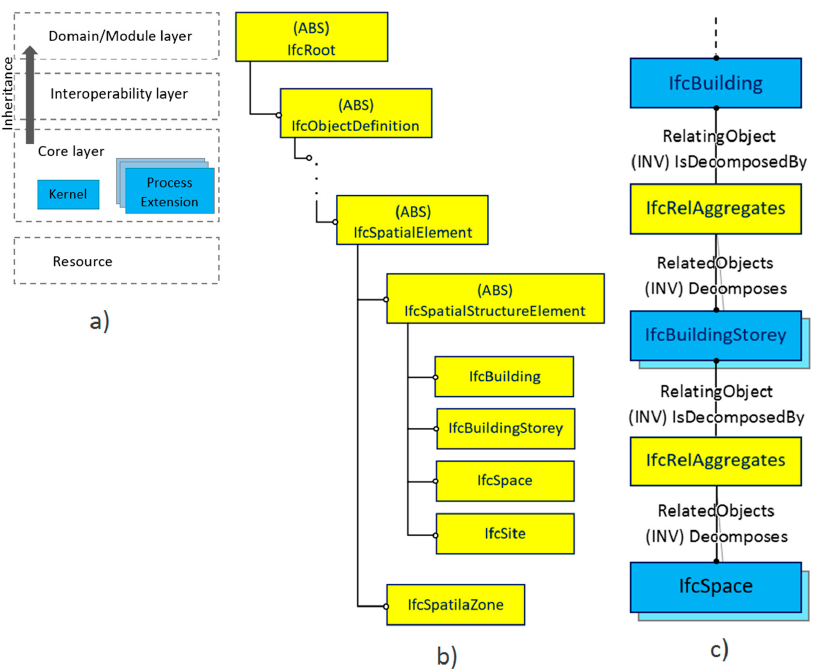
Figure 1. ( a ) A diagram of the IFC layers; ( b ) A diagram of the inheritance; ( c ) The decomposition of these spatial classes (adopted from ISO 16739-1